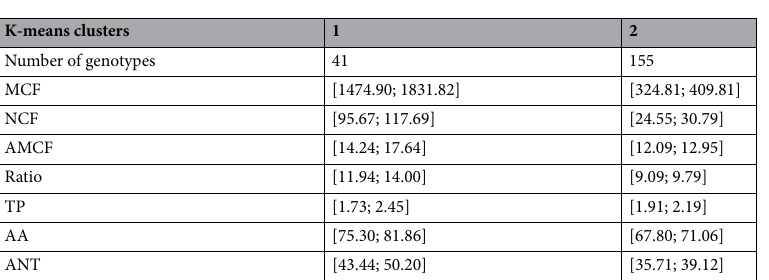
Table 1. Confidence interval of the mean values of the variables evaluated in the two K-means clusters with the respective number of genotypes ( p < 0.05). MCF mass of commercial fruits (g plant −1 ), AMCF average mass of commercial fruits (g fruit −1 ), NCF number of commercial fruits (fruits plant −1 ), Ratio, soluble solids